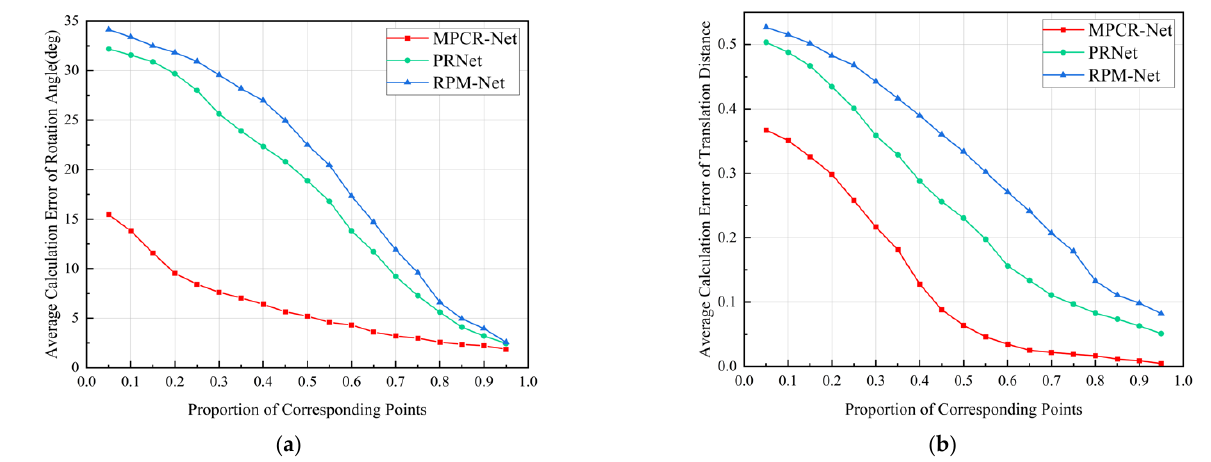
Figure 11. Average registration error with different proportions of correspondence points: ( a ) Average calculation error of rotation angle; ( b ) Average calculation error of translation distance.